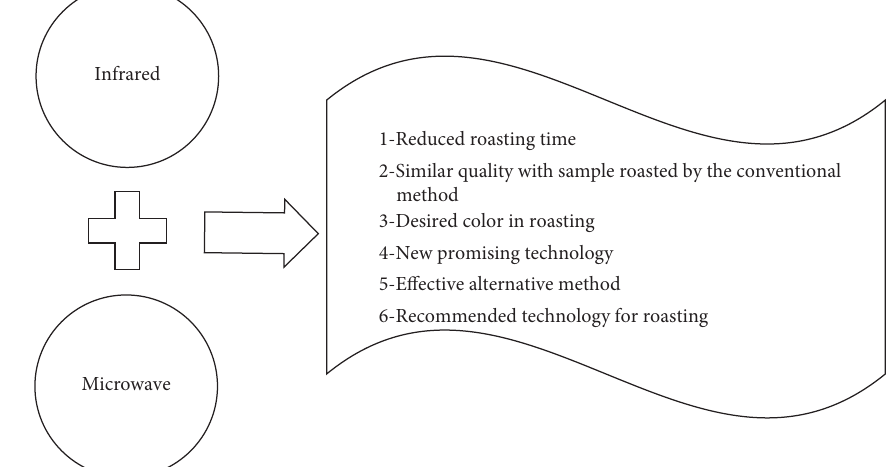
Figure 4: Combination of IR heating and microwave (IR-microwave) and its advantages.